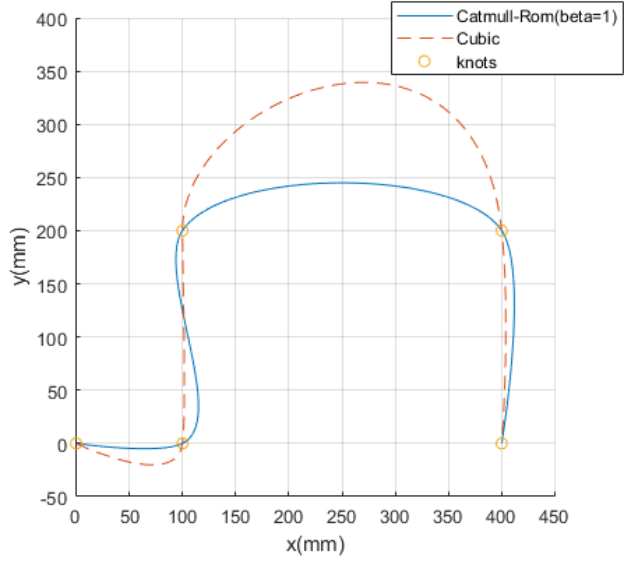
Figure 12. Path for five knots in the task #2 when two different methods are applied.